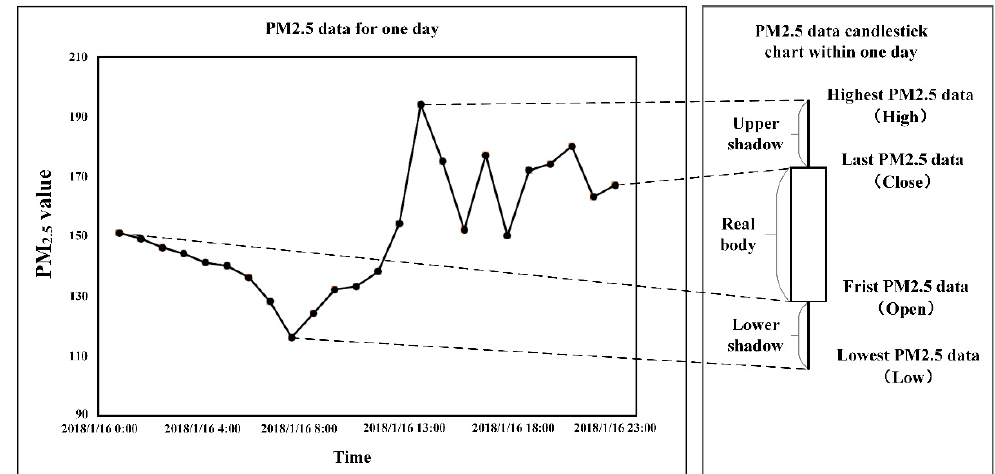
Figure 6. A PM 2.5 value candlestick chart within a day.